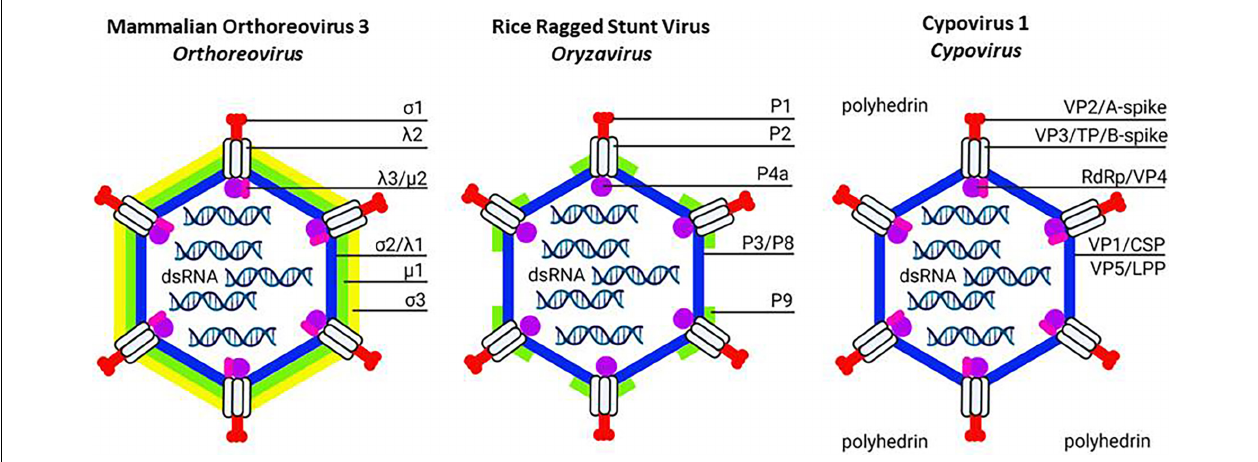
FIGURE 1 | Schematic structure of turreted reoviruses ( Spinareovirinae ): Mammalian orthoreovirus 3 ( Left ; Orthoreovirus ), Rice ragged stunt virus ( Middle ; Oryzavirus ) and Cypovirus 1 ( Right ; Cypovirus ). The transition from double-layered to single-layered particles is illustrated. In orthoreoviruses, the outer capsid consists of the T = 13/icosahedral layer of trimers (formed by µ 1; green) in complex with the protection protein ( σ 3; yellow). The T = 13/icosahedral layer of trimers is more limited in oryzaviruses (formed by P9; green) and absent in cypoviruses. Instead, cypovirus virions can become embedded in polyhedra formed by a three-dimensional network of polyhedrin protein. Characteristic turrets (formed by λ 2, P2 or VP3/TP/B-spike; gray) also serve to anchor the spike proteins at the exterior (formed by σ 1, P1 or VP2/A-spike; red) and the transcription complex at the interior (formed by λ 3/ µ 2, P4a or RdRp/VP4; purple-pink). The inner shell with clamp (formed by σ 2/ λ 1, P3/P8 or VP1/CSP-VP5/LPP; blue) encapsulates the dsRNA segments of the genome. Created with BioRender.com.